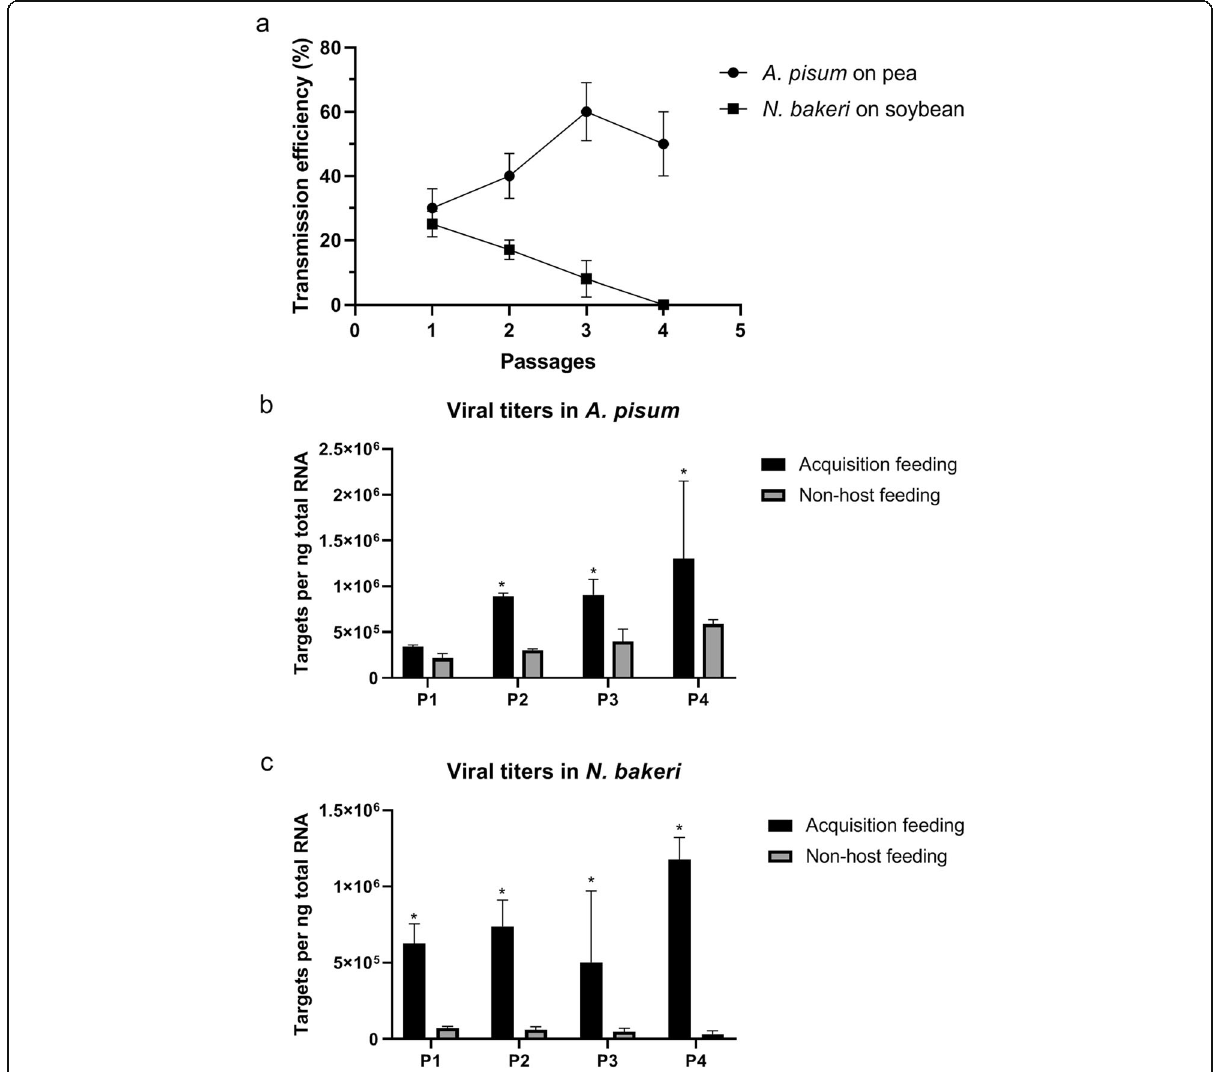
Fig. 1 Transmission efficiency and virus titers of SbDV-MD6 transmitted by aphids A. pisum and N. bakeri on pea and soybean, respectively. a The transmission efficiency on pea and soybean hosts. The percentages were determined by infected plants of total plants in each experiment. Two independent experiments were performed. b Virus titers of SbDV-MD6 in A. pisum at the acquisition and retention stage through serial passages. c Virus titers of SbDV-MD6 in N. bakeri at the acquisition and retention stage through serial passages. Error bars represent the standard deviation of the mean. Statistical significance levels (determined by ANOVA test, P < 0.5) were denoted by